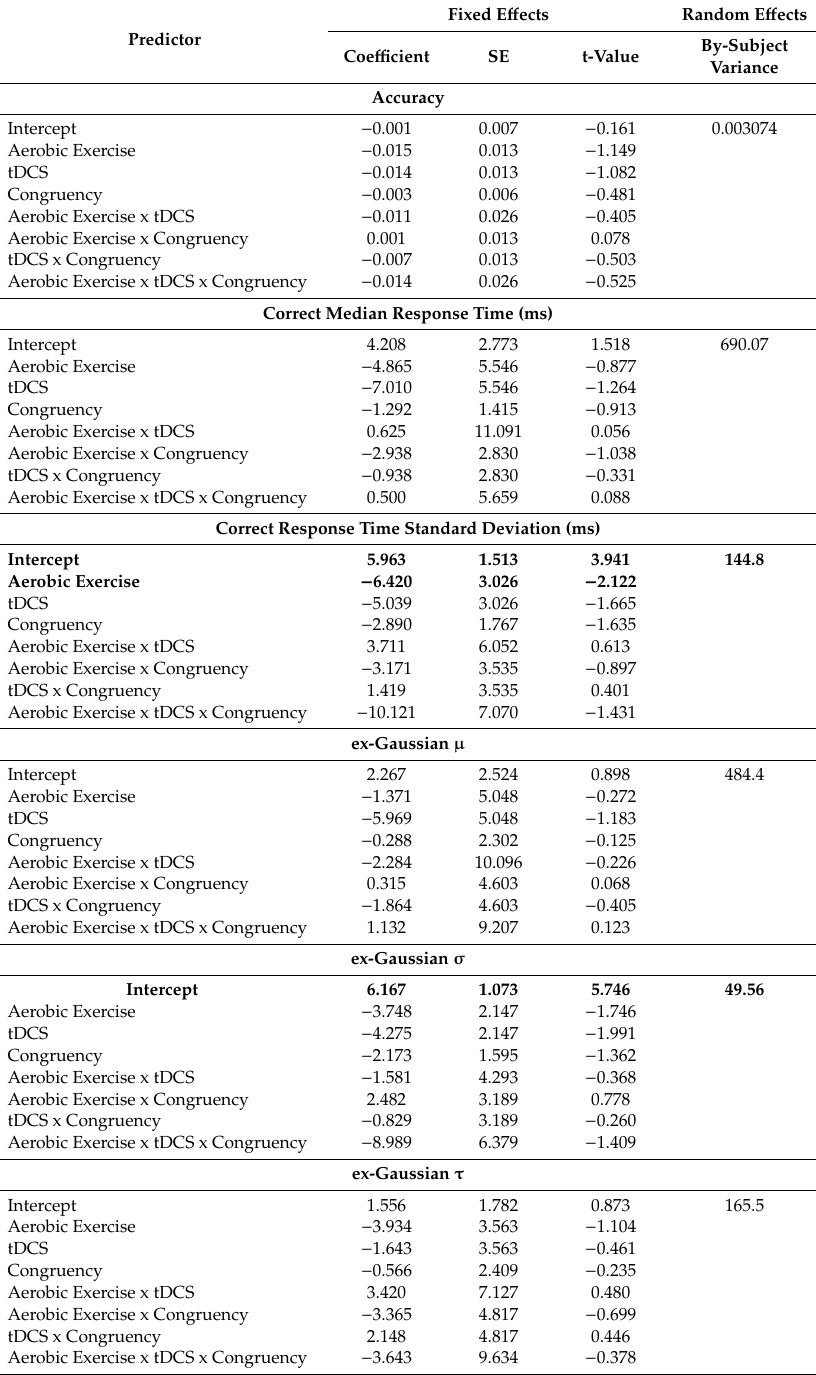
Table 2. Linear mixed-e ff ect model output of Aerobic Exercise (Seated vs. Exercise), tDCS (Active vs. Sham), and Congruency (Incongruent vs. Congruent) on the flanker task for accuracy, median correct response time, correct response time standard deviation, and ex-Gaussian parameters ( µ , σ , and τ ). Bolded model parameters indicate significant findings (i.e., t > | 2.00 | ). SE = Standard